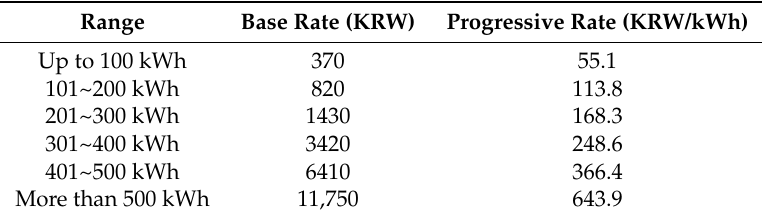
Table 1. Korean progressive electric rate (US$1 ≈ 1100